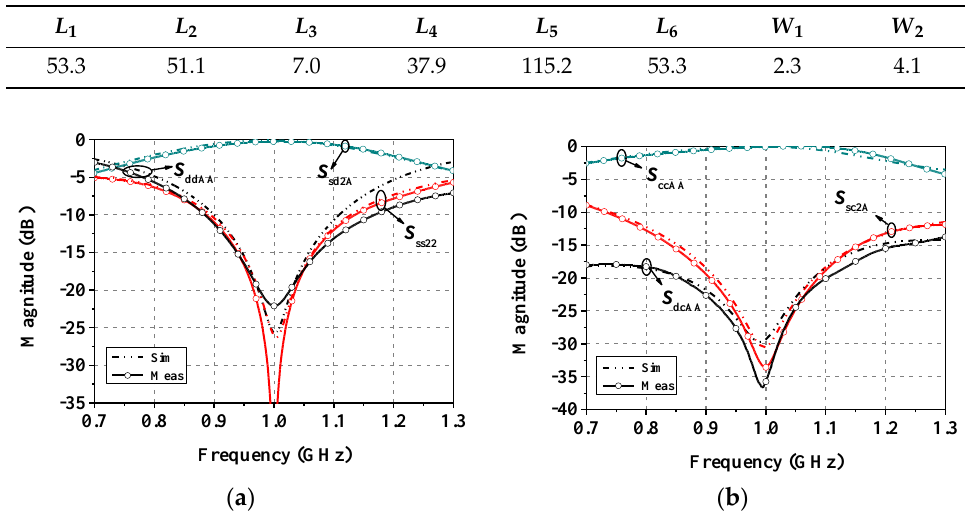
Table 4. Performance comparison.